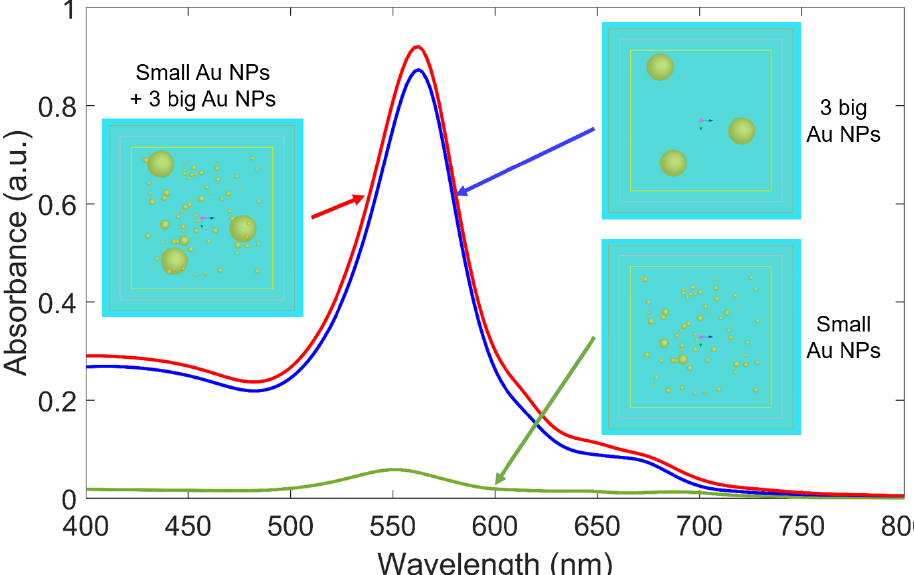
Figure 6. Absorption spectra of Au NPs in three cases: (i) only small Au NPs with the size of around 10 nm, (ii) only 3 big Au NPs with the size of 50 nm, and (iii) the combination between many numbers of small Au NPs and 3 big Au NPs. The three insets show the top view of the corresponding three simulation models using FDTD. The refractive indices of surrounding medium (SU-8) and glass substrate are 1.58 and 1.48,